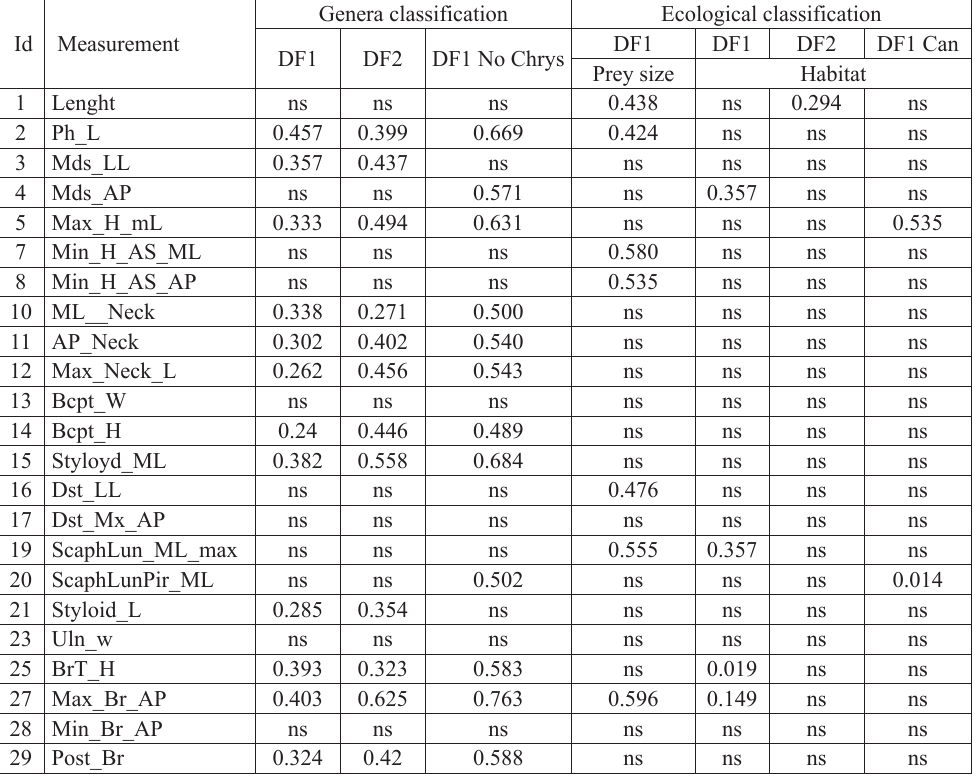
Table 3. Correlation coefficient of the relationship between selected variables and extracted discriminant functions after different analyses based on the overall sample (N = 92), on a subsample inclusive of all species except Chrysocyon (No Chrys, N = 88), or on a subsample of large Canini only (Can, Canis spp. + Lycaon , N = 36). DF, Discriminant Function; ns, non-significant. For explanation of measurement abbreviations see Table 1.